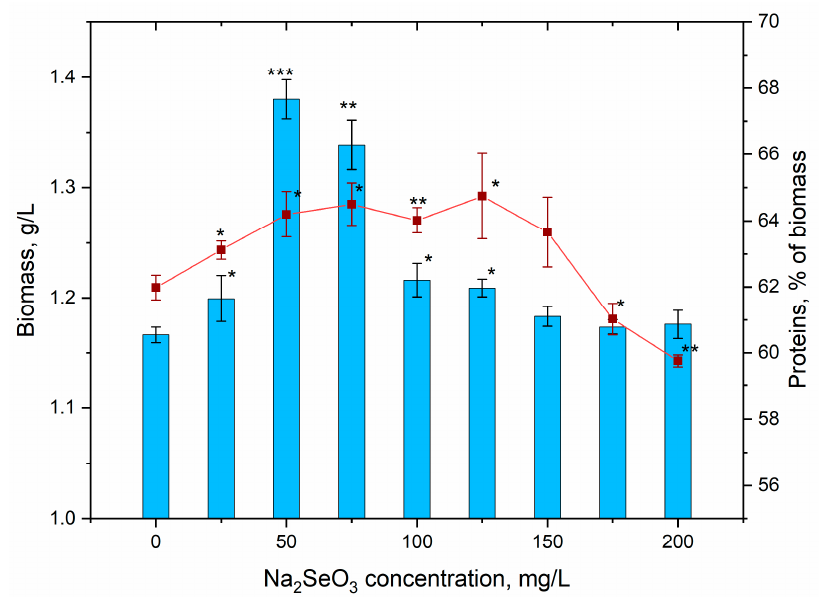
Figure 4. Accumulation of Arthrospira platensis biomass and content of protein in biomass under conditions of supplementing the nutrient medium with sodium selenite (* p < 0.05, ** p < 0.005, *** p < 0.0005 for differences between control and experimental sample; n = 3). The error bars represent the standard deviation of the measurements.